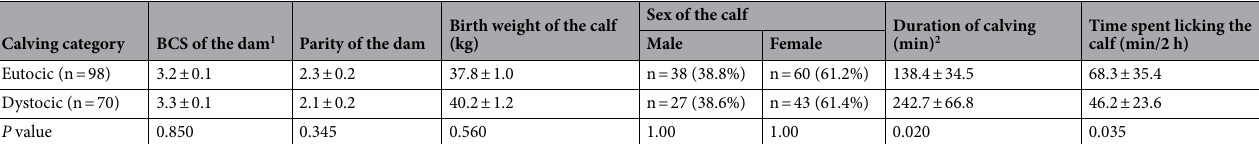
Table 1. Characteristics of calvings involved in this study (means ± SEM). 1 BCS of the dam was scored using the 5-point USA scoring system 18 following calving. 2 Between the onset of calving restlessness and delivery (including stages 1 and 2 of labor). Statistical significances are based on the Welch’s two-sample t test in cases of BCS and parity of the dam, birth weight of the calf, duration of calving and time spent licking the calf. The proportions of male and female calves were compared between groups with the Pearson’s Chi-squared